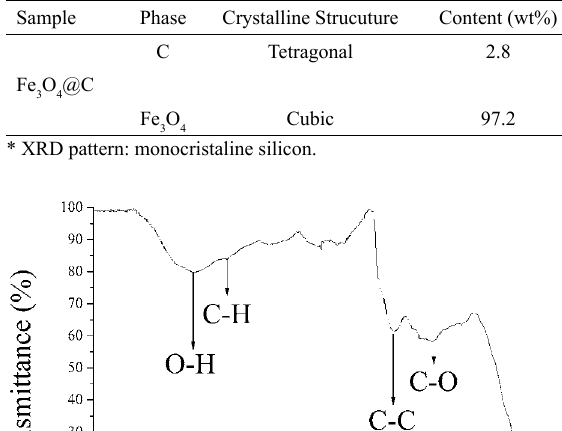
Figure 5. Determination of pH